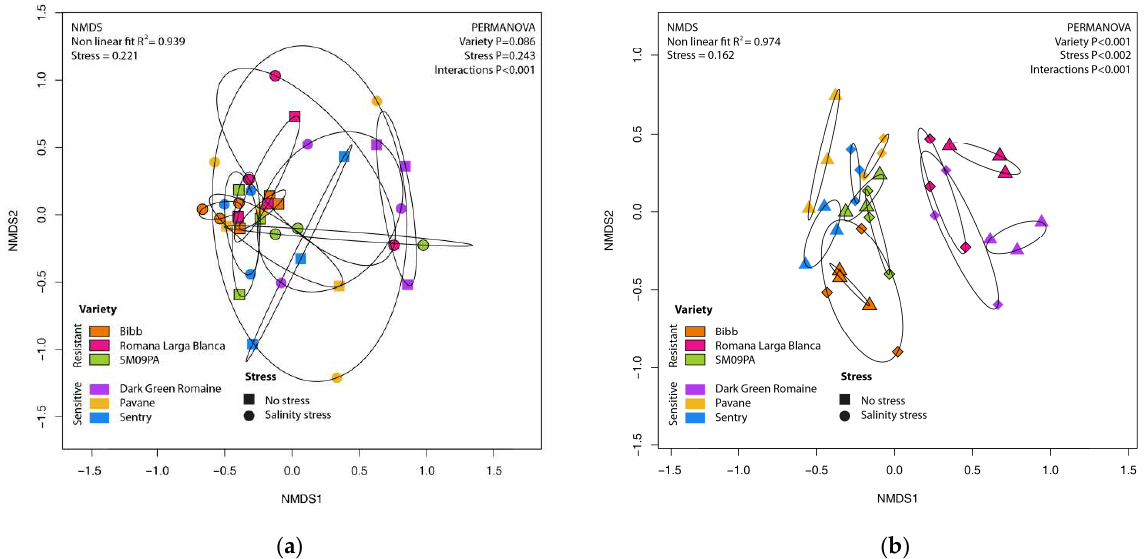
Figure 5. NMDS scatterplot of fungal community in roots ( a ) and rhizosphere ( b ) of six lettuce varieties in normal conditions and under salinity stress.